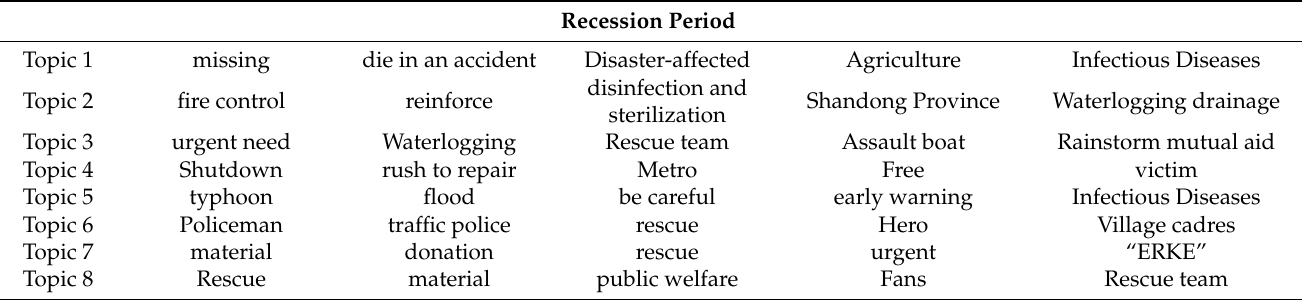
Table 3. Text topic extraction results in the recession period.